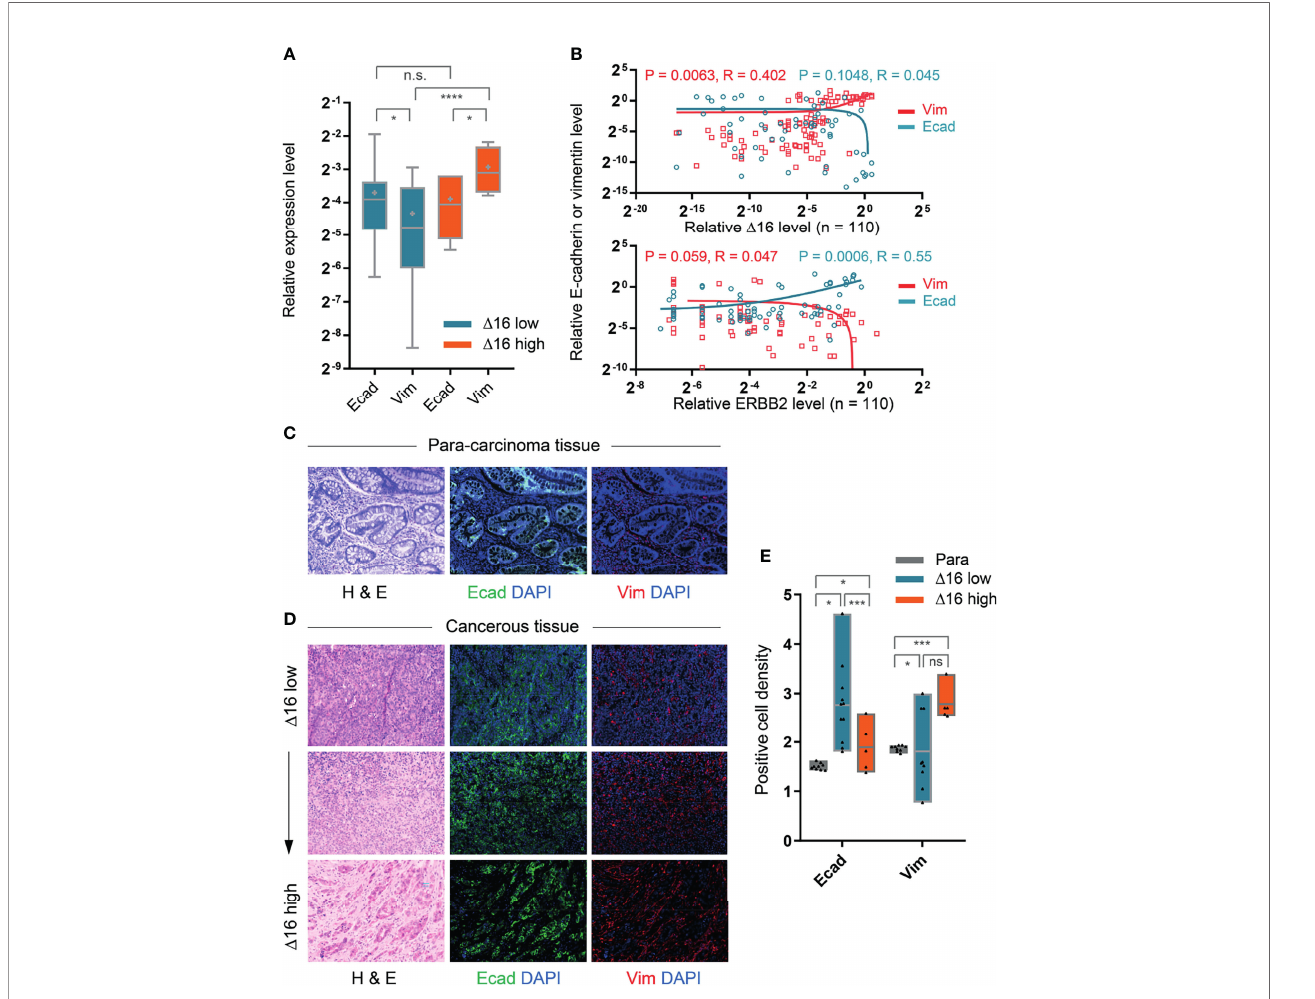
FIGURE 2 | Correlation of high ERBB2d16 expression with EMT-like phenotype. (A) Relative mRNA expression levels of E-cadherin (Ecad) and vimentin (Vim) in ERBB2d16 ( D 16) -low (n = 67) and -high (n = 43) groups, respectively. (B) The correlations between ERBB2 isoforms and EMT markers (E-cadherin and vimentin) by the Pearson ’ s correlation analysis (n = 110); (C, D) . Hematoxylin and eosin (H&E) and immuno fl uorescent staining (E-cadherin and vimentin) of paired para-carcinoma tissue (C) and tumor tissues (D) . Scale bar, 100 m m; (E) . The expression of E-cadherin and vimentin, which was represented by the density of positive cells, in tumor tissue of low ERBB2d16 (n = 20), of high ERBB2d16 (n = 20), and paired para-carcinoma tissues (n = 40). (*p < 0.05, **p < 0.001, ***p < 0.0001, ****p < 0.00001), ns, not signi fi cant. D 16 low: ERBB2d16/ERBB2 ratio < 0.88; D 16 high: ERBB2d16/ERBB2 ratio ≥ 0.88. ERBB2: human epidermal growth factor receptor-2; ERBB2d16: ERBB2 D Ex16